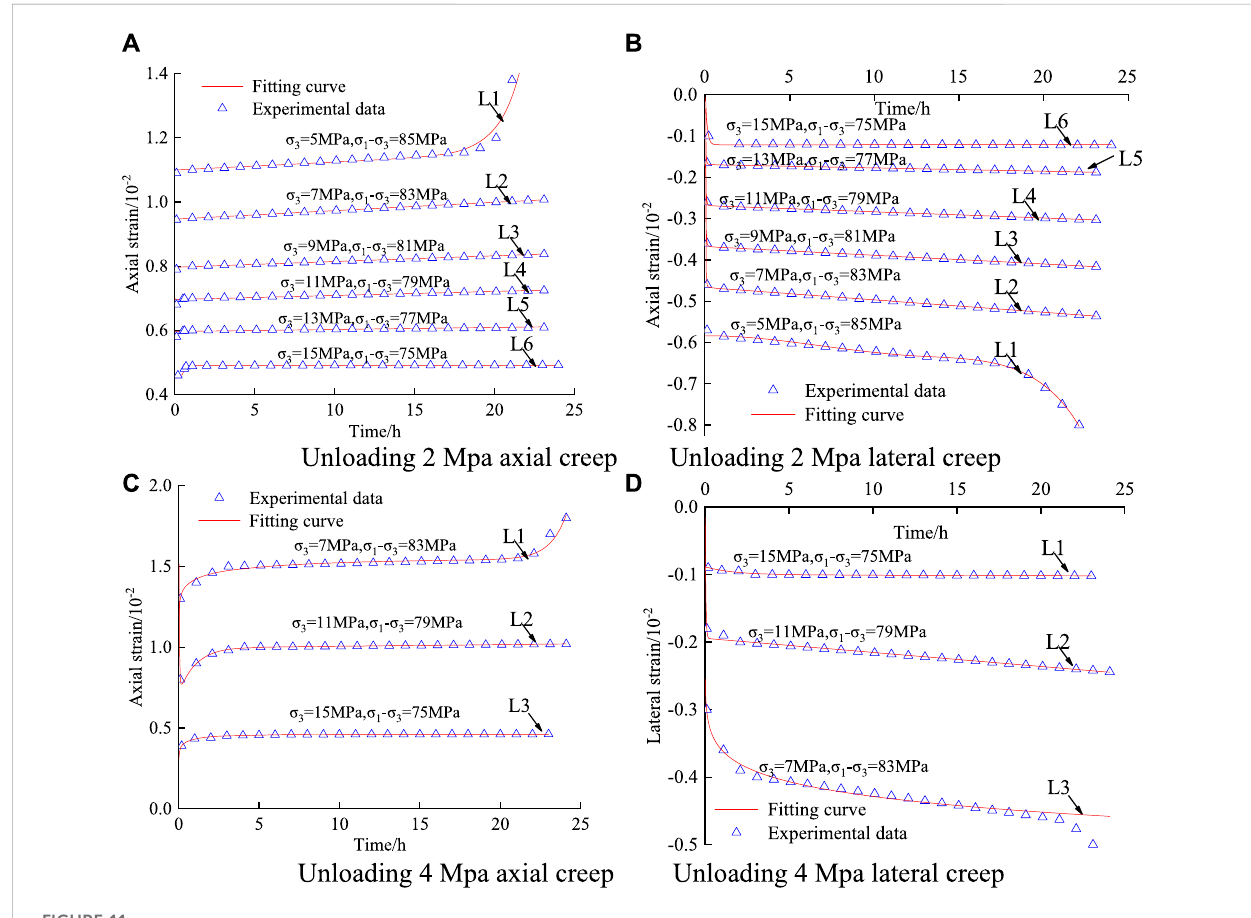
FIGURE 11 Creep curve and model curve fi tting results. (A) Unloading 2 Mpa axial creep (B) Unloading 2 Mpa lateral creep. (C) Unloading 4 Mpa axial creep (D) Unloading 4 Mpa lateral